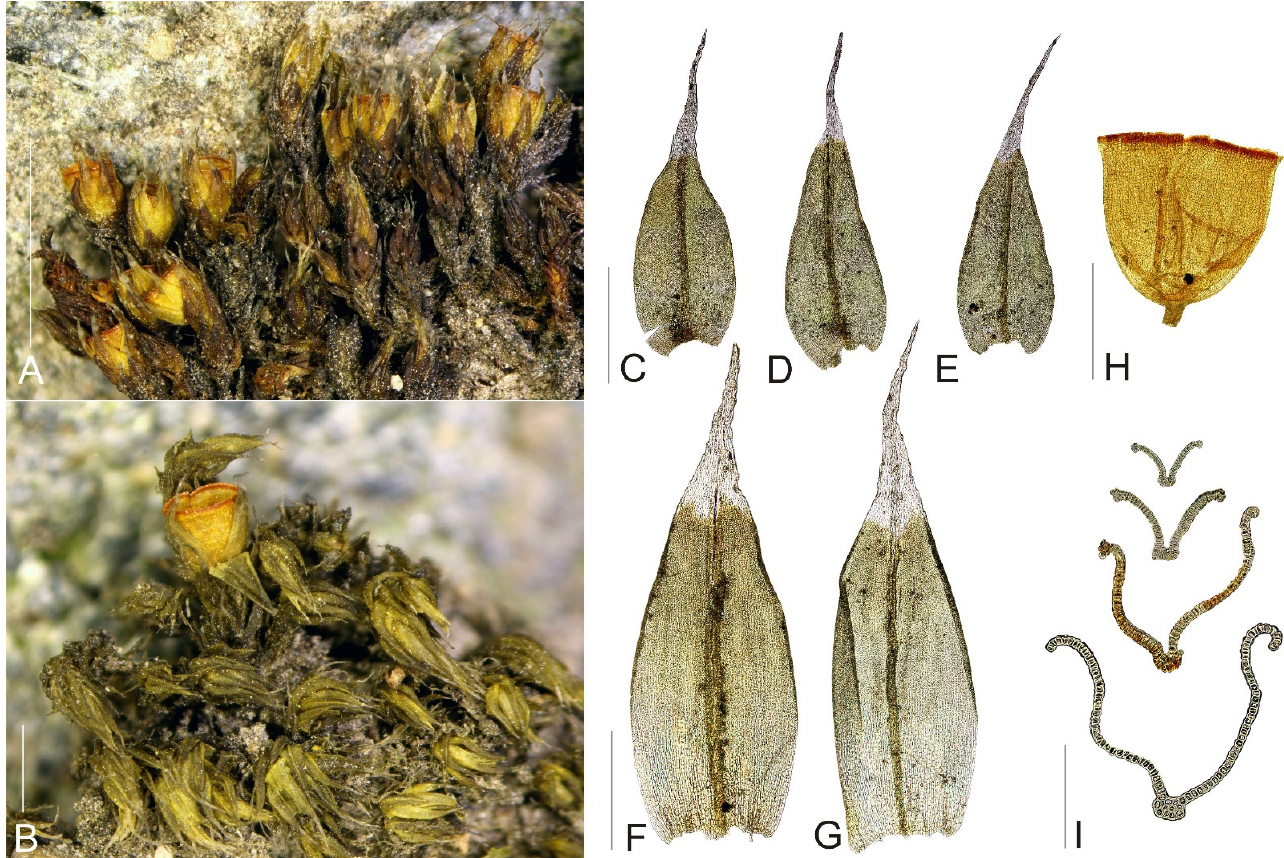
Figure 1. Macro and micro photographs of Schistidium flaccidum : ( A , B ) view on fertile plants; ( C – E ) leaves; ( F , G ) perichaetial leaves; ( H ) capsule; ( I ) leaf cross-sections (from the base of the leaf to the tip). Scale bars: A , B —1 mm, C – H —0.5 mm, I —0.1 mm. All photos from specimen OSTR #7250, made by V. Plášek.